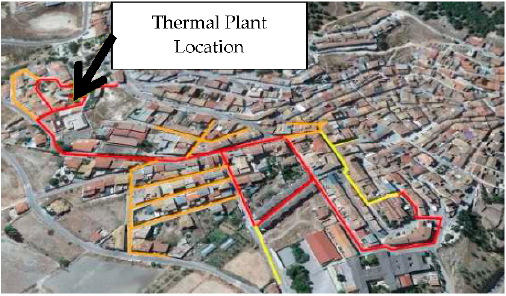
Figure 2. Network layout. Main distribution network (red lines) and secondary distribution network (yellow and orange lines).